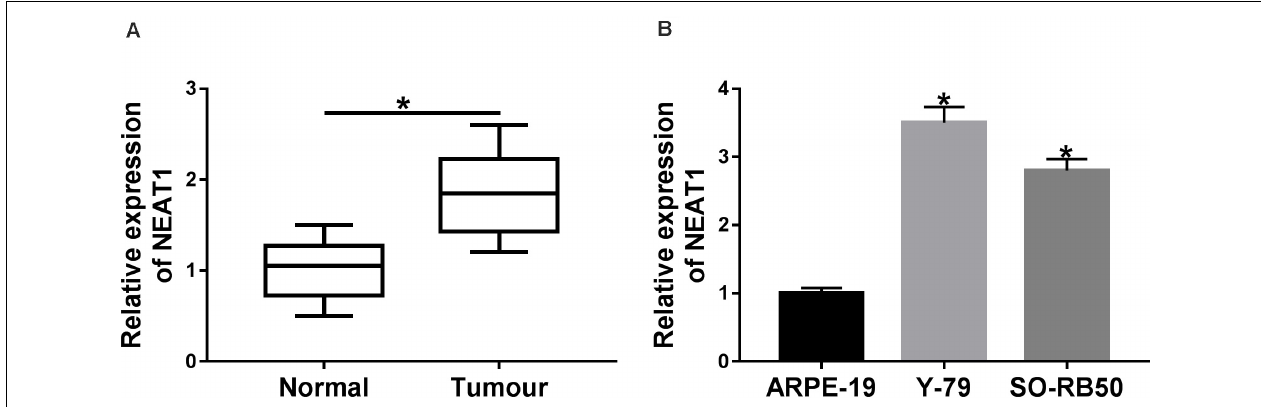
FIGURE 1 | NEAT1 expression level was dramatically up-regulated in RB tissues and cells. (A) The expression of NEAT1 in RB tissues and adjacent normal tissues was detected by qRT-PCR. (B) NEAT1 expression level in RB cells and ARPE-19 cells was assessed by qRT-PCR. * P < 0.05.